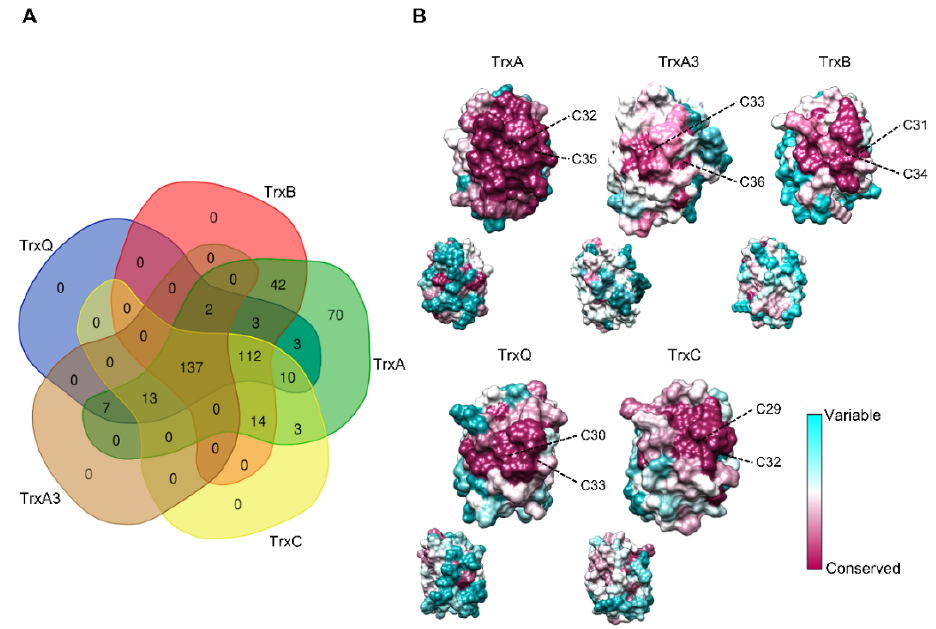
Figure 2. Distribution and conservation of cyanobacterial Trxs. ( A ) Venn diagram showing co-occurrence of Trxs in cyanobacteria analyzed. The specific cyanobacteria for each category are available in the Table S1. ( B ) Residue-based conservation score plotted for models of TrxA1/2, TrxA3, TrxB, TrxQ, and TrxC. Residues are colored according to conservation scores ranging from 1 (cyan, least conserved) to 9 (purple, most conserved). The active-site cysteines are indicated for each model.